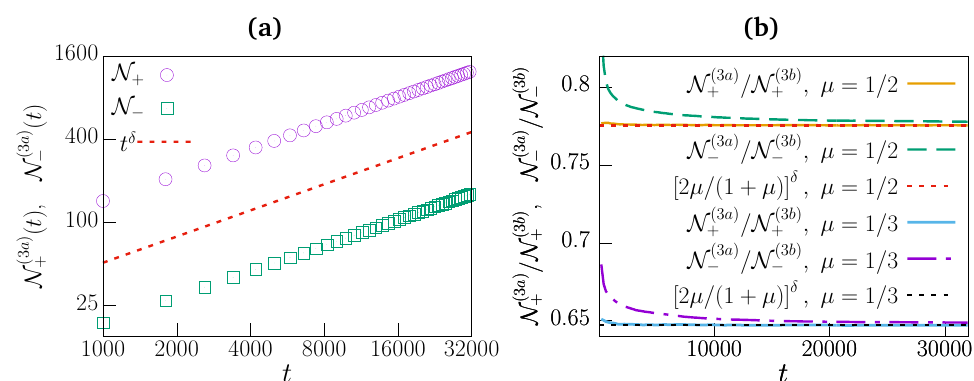
Figure 4: Panel (a): Comparison of microscopic simulation results with analytic pre- dictions for the time-dependence of the total number of excited particles N − ( t ) in the x < 0 region and the number N + ( t ) in the region x > 0 for the mass arrange- ment (3a). The particles are distributed uniformly with density ρ ∞ = 1, v 0 = 1, and m = 2 / 3, M = 4 / 3. Panel (b): Here we test the prediction, Eq. (8), that the ratio of the values of N + ∼ nR ( t ) (and N − ), obtained from the two arrangements (3a) and (3b) is given, at long times, by the µ -dependent factor 2 µ /( 1 + µ ) . In all cases, averages are taken over 2 × 10 5 realizations. The value of β given by Eq. (26) was used, with δ = ( 2 − β )/